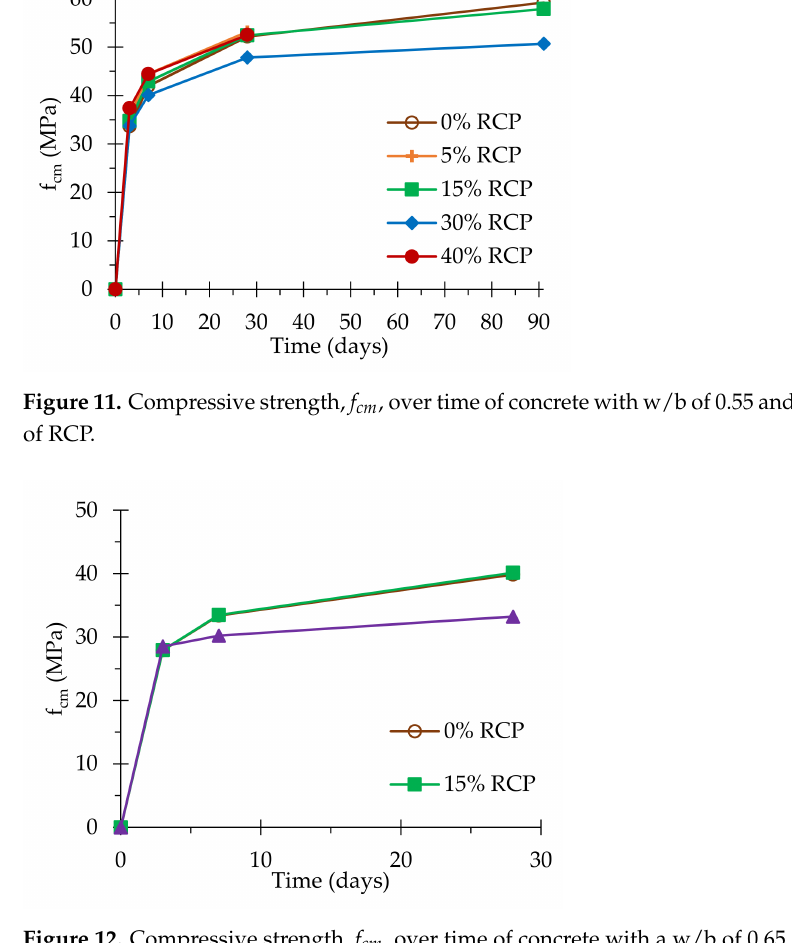
Figure 12. Compressive strength, f cm , over time of concrete with a w/b of 0.65 and different incorpo- ration percentages of RCP.